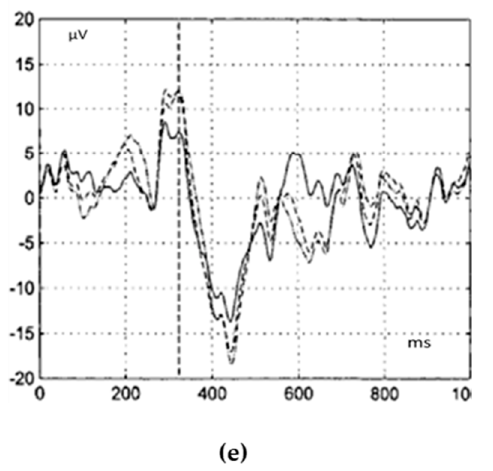
Figure 7. Audiological assessment in a subject with Brown–Vialetto–Van Laere syndrome-related auditory neuropathy spectrum disorder (ANSD), resulting in neural impairment of the 8th and 12th cranial nerves and the optic nerves. Unaided pure-tone audiometry (( a ), both ears) shows bilateral hearing loss mainly for low frequencies. Unaided free field speech discrimination is poor (( b ), 10% gray dot at 80 dB). Aided tonal and speech perception outcomes with acoustical hearing aids remain poor and comparable to unaided perception. The latter clearly improves after cochlear implantation (CI) (( b ) , black line). Otoacoustic emissions (OAEs) are present (( c ), spectral analysis of OAEs in the white area, compared to noise in the black area), whereas auditory brainstem responses (ABRs) synchronization was abnormal with no wave V but a clear cochlear microphonic (CM) in both rarefaction (R) and condensation (C) polarities and in the subtraction R − C ( d ). Cortical auditory evoked responses ( e ) show a P3 complex after stimulation with an oddball paradigm and in selective attentive conditions only, even if no recordable N100 or P200 waves are present in responses to the frequent stimuli (not